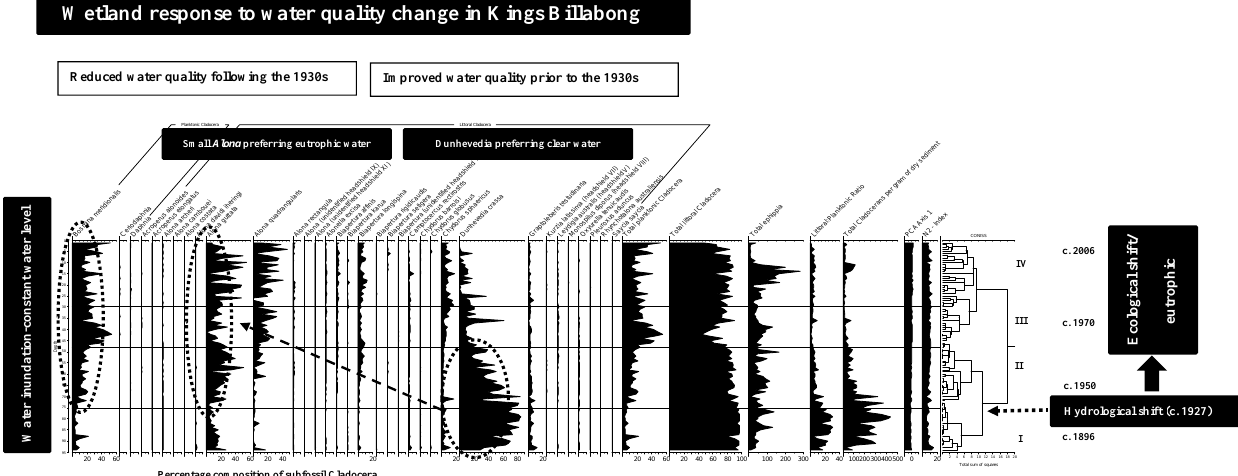
Figure 3. Percentage composition and N2 diversity index of subfossil cladocerans in Kings Billabong, their response to past hydrological and water quality change.